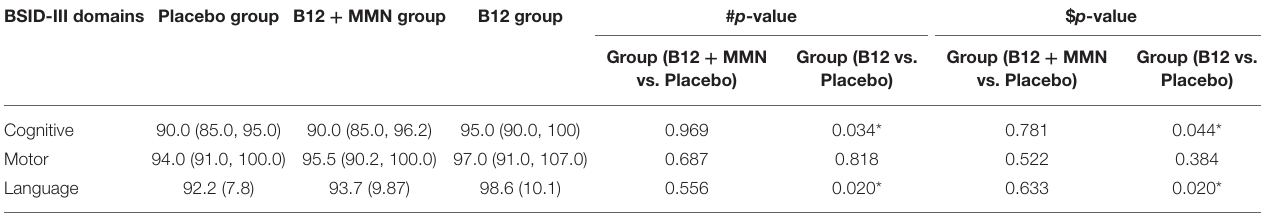
TABLE 2 | Comparison between placebo and supplemented groups in BSID-III domains. BSID-III domains Placebo group B12 + MMN group B12 group # p -value